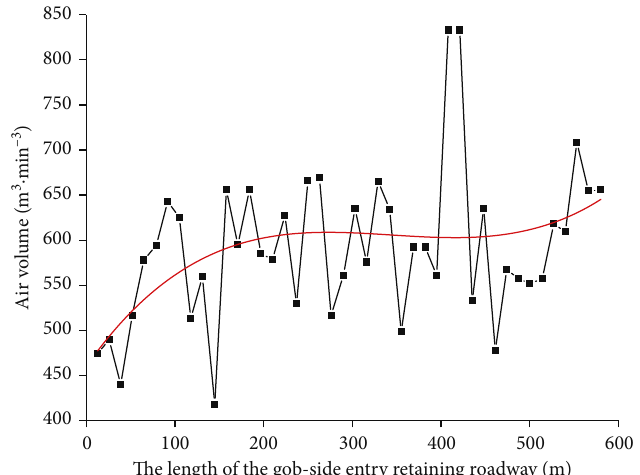
Figure 6: Air volume along the RCGSER roadway.